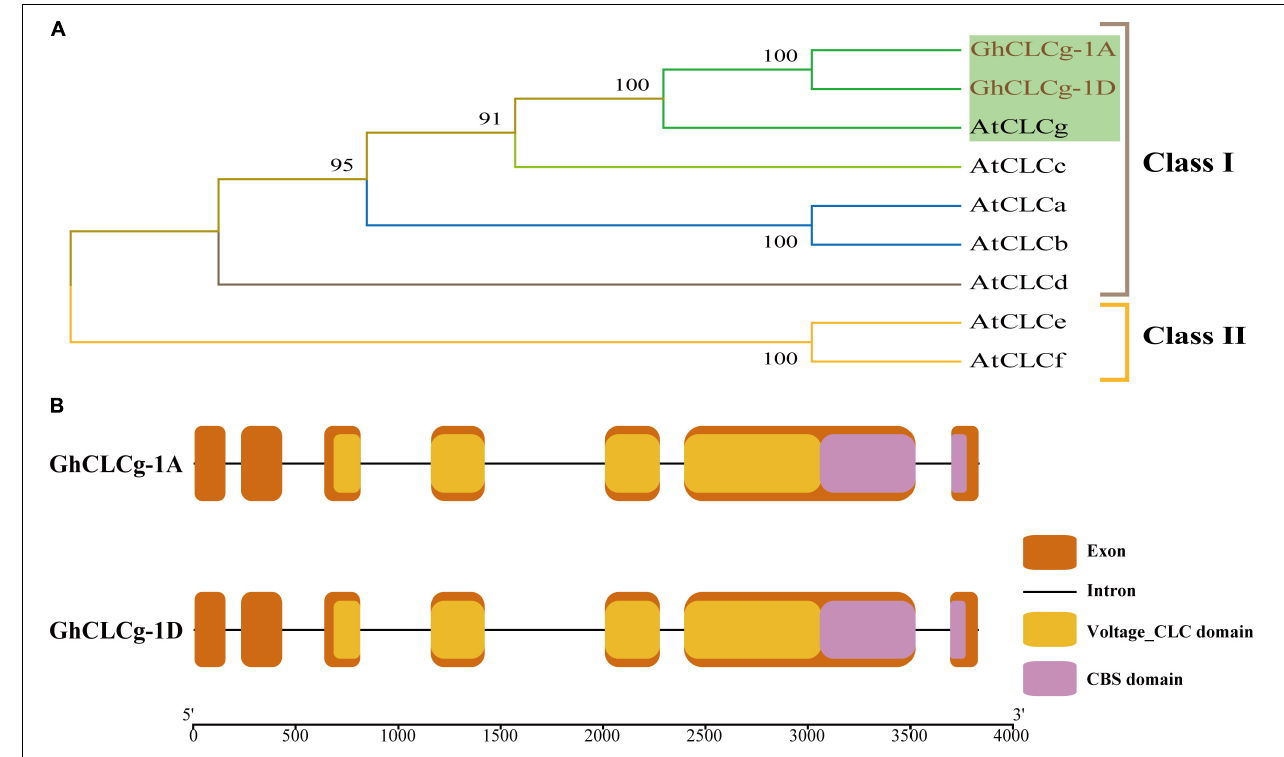
FIGURE 2 | Phylogenetic analysis and gene structures of GhCLCg-1A/D. (A) Phylogenetic tree of GhCLCg-1A/D ( Gossypium hirsutum ) and AtCLCs ( Arabidopsis thaliana ). (B) Intron-exon and conserved domains structures of GhCLCg-1A/D. The exons, introns, Voltage_CLC domains and CBS domains are indicated by the orange boxes, black lines, yellow boxes, and purple boxes, respectively. The 5 (cid:48) -3 (cid:48) scale indicates the size of DNA sequence. The exons/introns and domains sizes are proportional to DNA sequence lengths.